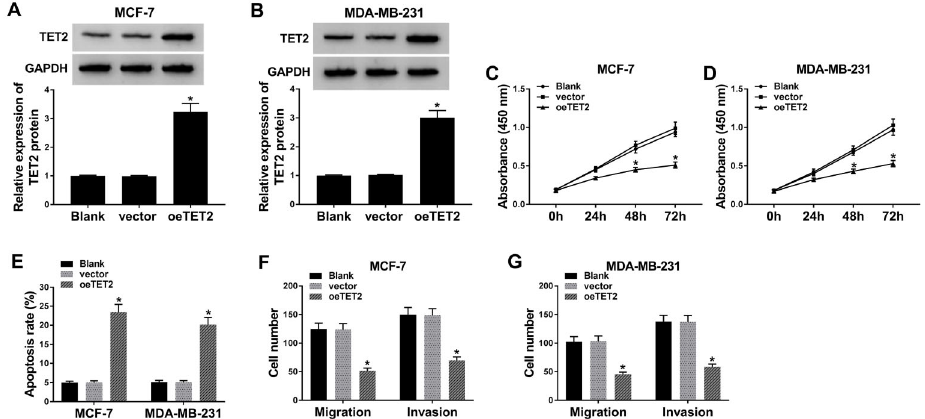
Figure 4. MCF-7 and MDA-MB-231 cells were transfected with vector or TET2 overexpression plasmid (oeTET2). A and B , The expression of TET2 was detected in MCF-7 and MDA-MB-231 cells (n=3) by qRT-PCR after transfection for 24 h. C and D , CCK8 assay was conducted to measure the proliferation of breast cancer (BC) cells (n=6). E , Cell apoptosis was evaluated in the two cell lines (n=3) by fl ow cytometry after transfection for 72 h. F and G , Cell migration and invasion were assessed by transwell migration and invasion assays after transfection for 24 h (n=3). Data are reported as means ± SD. *P o 0.05